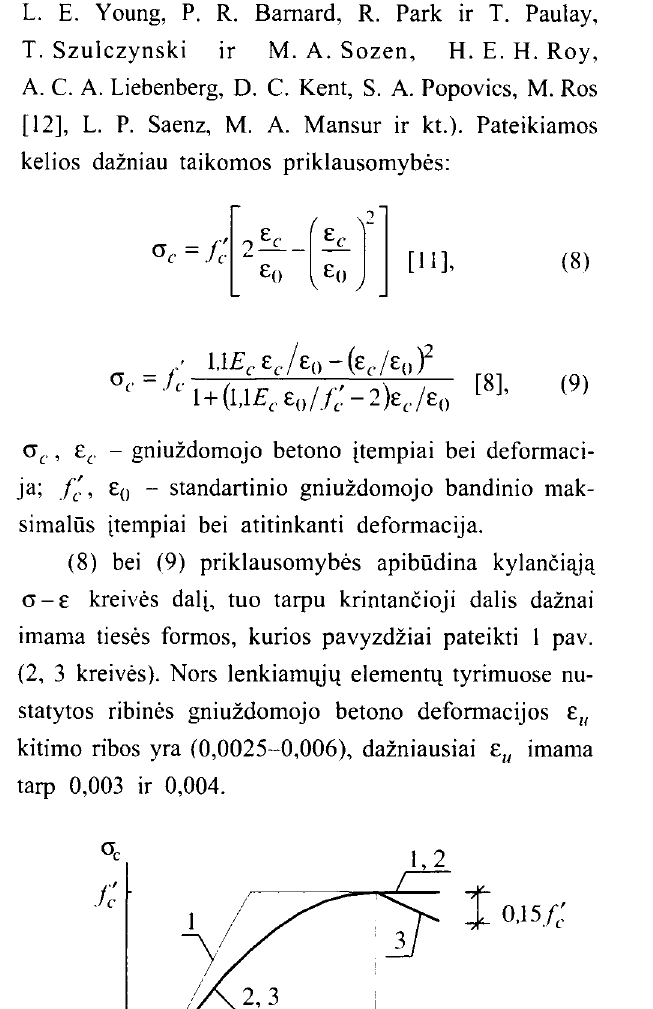
Fig 1. Constitutive relationships for compressive concre te: I - ideal elastic-plastic. 2 - elastic-plastic with work hardening, 3 - elastic-plastic with workhardening and strain